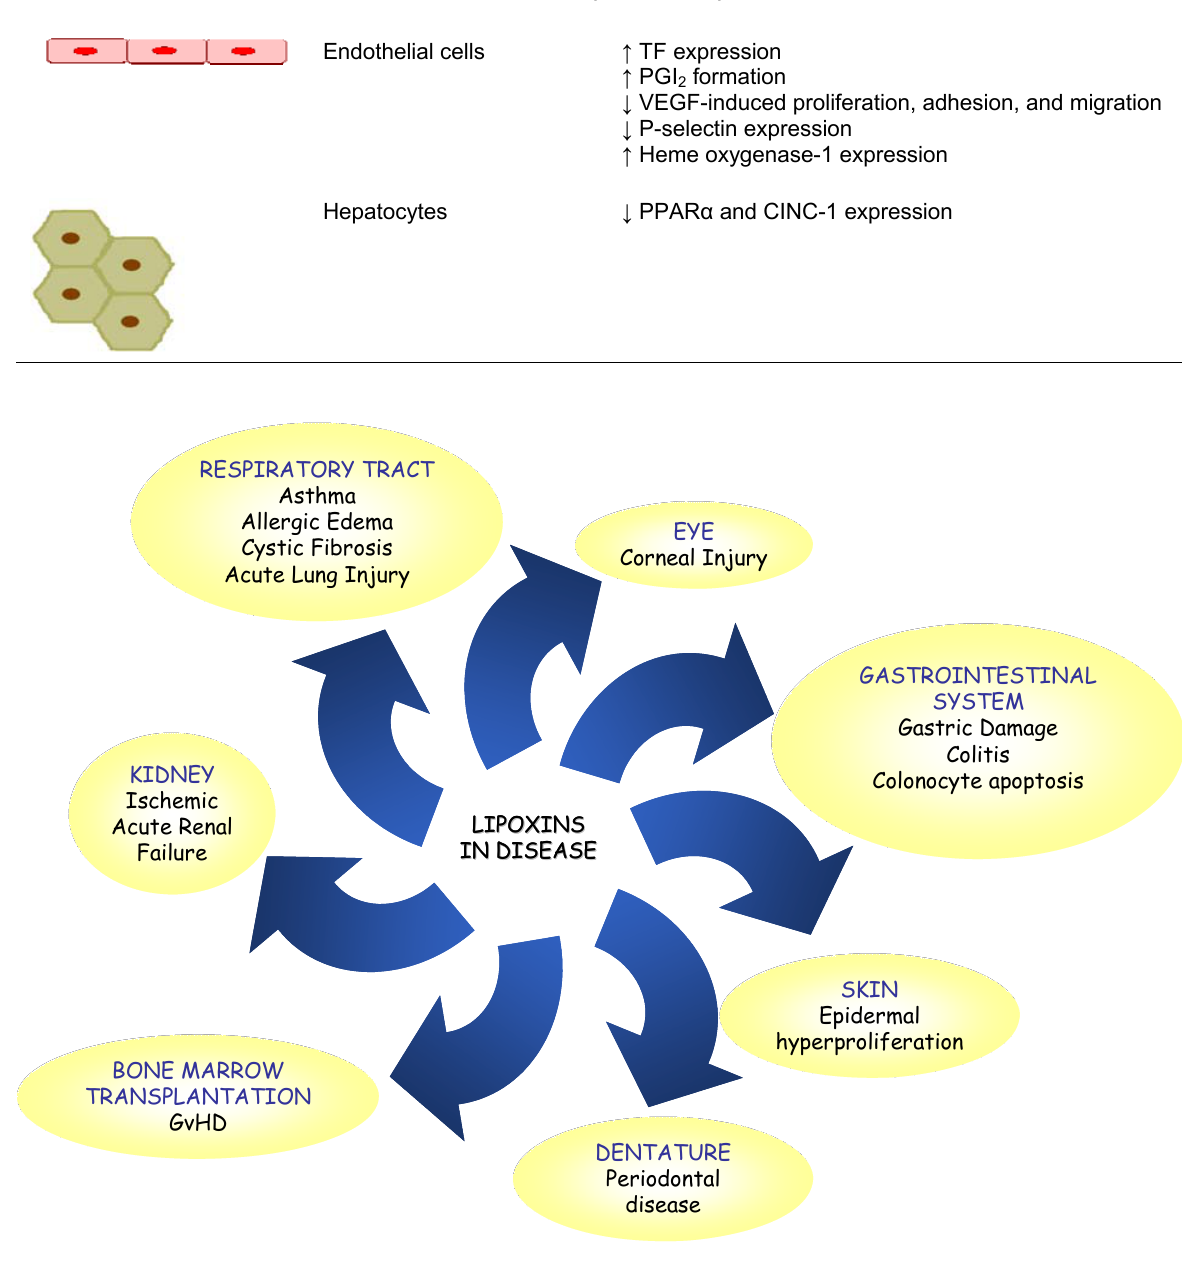
FIGURE 4 . LX in human disease (see text for